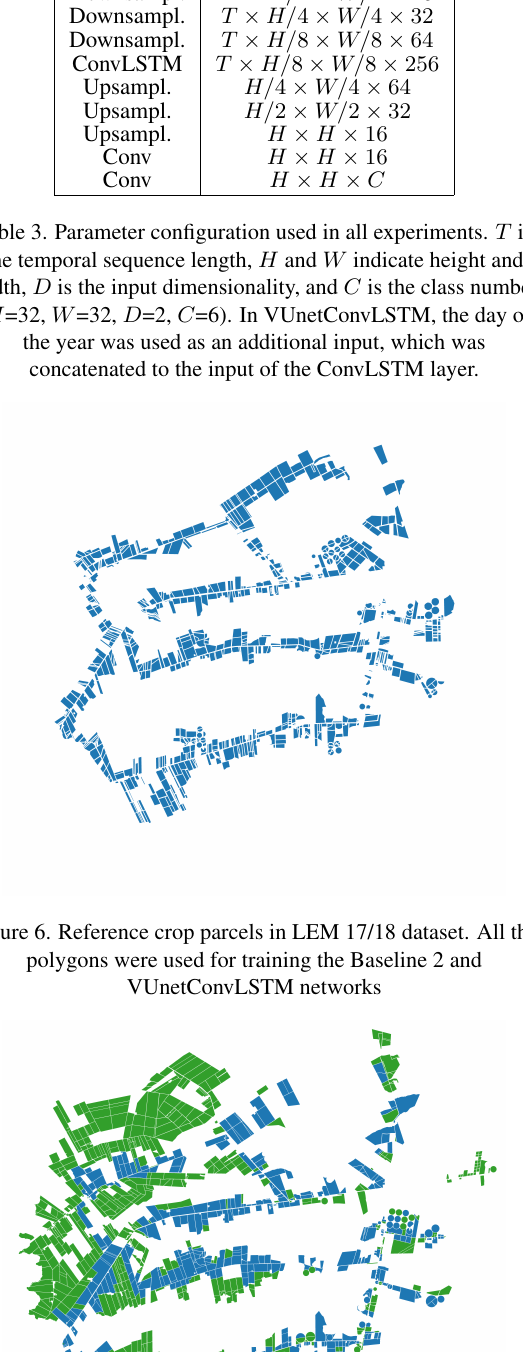
Figure 8. Per-date Overall Accuracy for the proposed